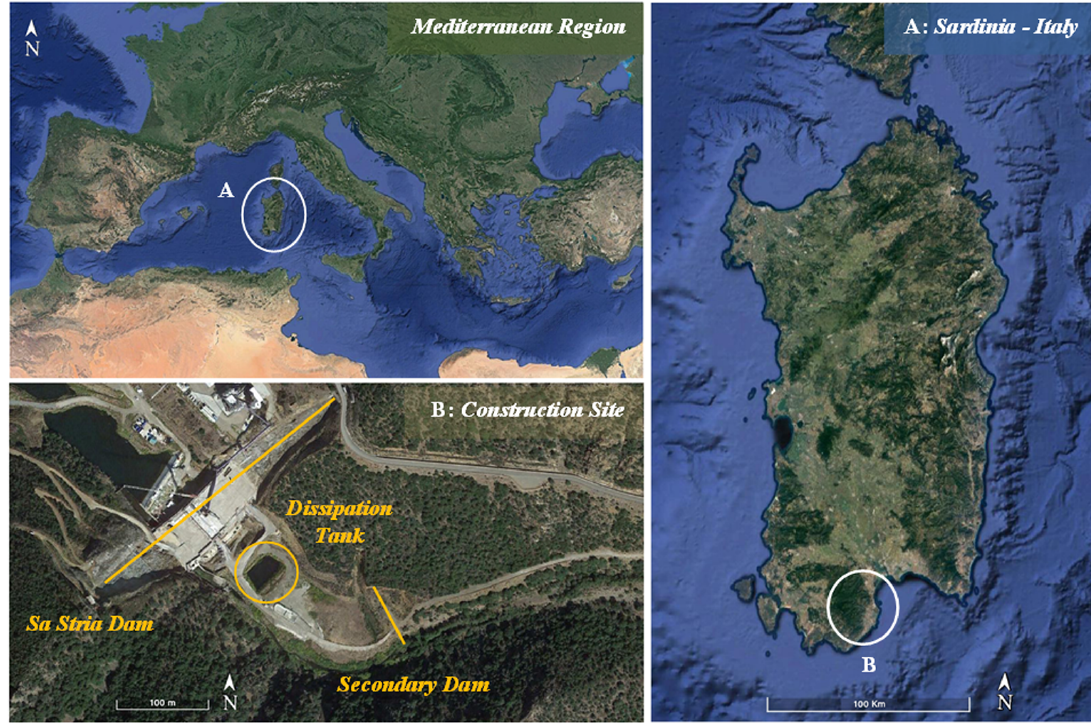
Figure 1. Location of Sa Stria Dam, Sardinia (Italy). The planned position of the main and secondary dam, as well as the dissipation tank are shown in the construction site